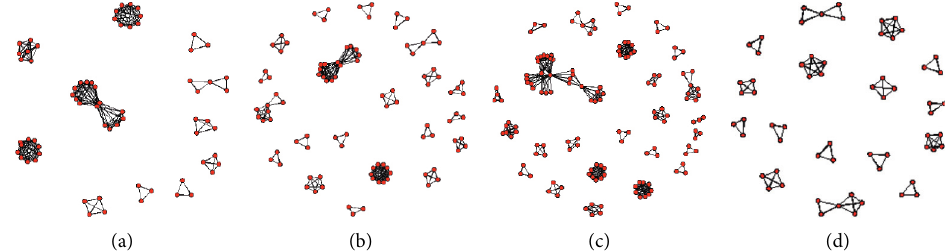
Figure 3: Proposed research model.